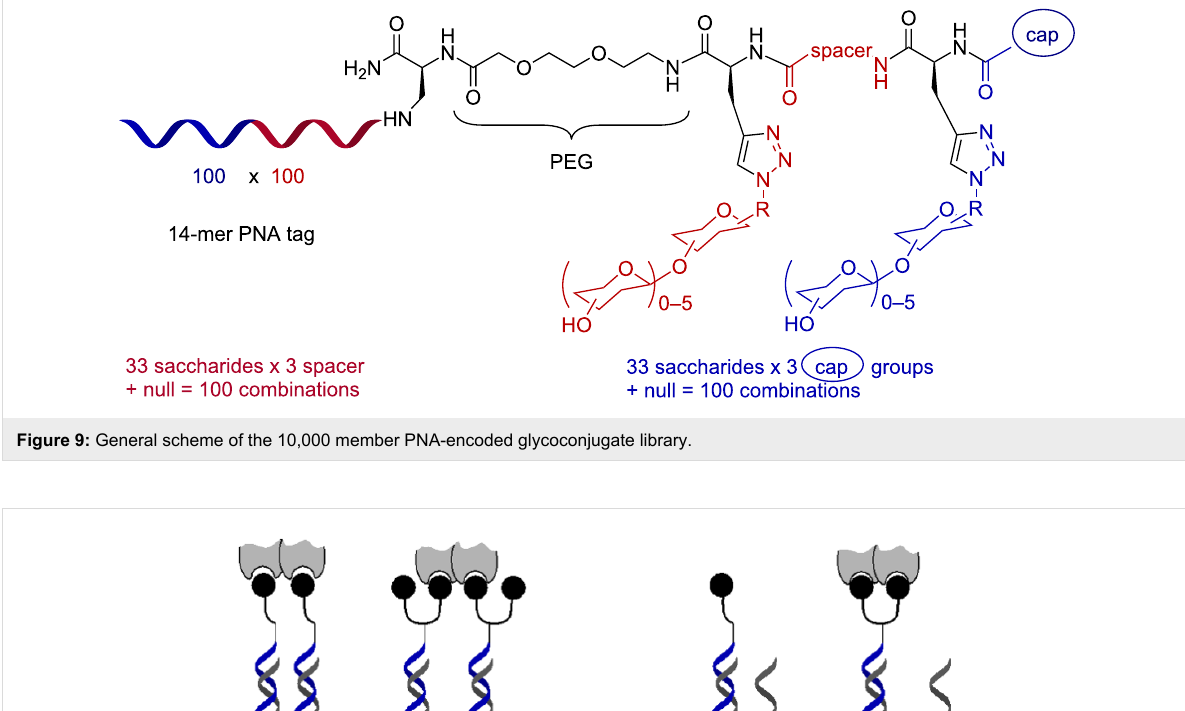
Figure 10: Oligomeric interaction with arrayed mono- and divalent ligands (represented as the black spheres) as a function of surface